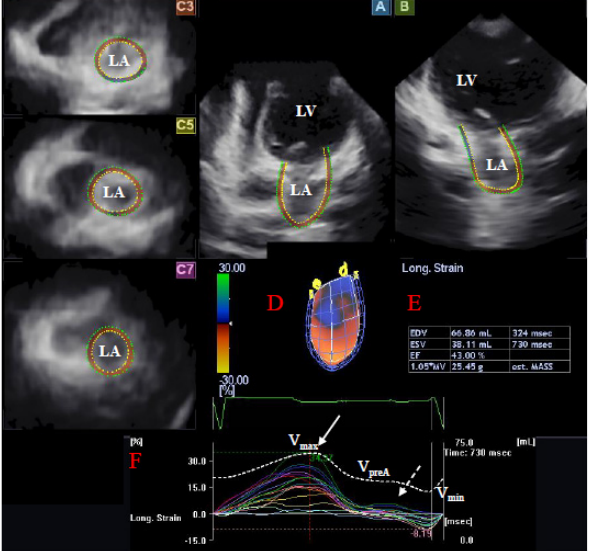
Figure 1. Three-dimensional (3D) speckle-tracking echocardiographic left atrial (LA) analysis using a full-volume dataset in an operated patient with dextro-transposition of the great arteries is presented: ( A ) apical four-chamber view, ( B ) apical two-chamber view, ( C3 ) short-axis view at basal, ( C5 ) mid- and ( C7 ) superior left atrial level. The 3D model of the LA ( D ) and LA volumetric data ( E ) are also presented. Colored curves represent time–LA segmental strains, while dashed curve represents LA volume changes during the cardiac cycle with maximum (V max ), minimum (V min ) LA volumes, and LA volume before atrial contraction (V preA ) ( F ). White arrow represents peak LA strain, while dashed arrow represents LA strain at atrial contraction ( F ). LA = left atrium, LV = left ventricle, V max = maximum LA volume, V min = minimum LA volume, V preA = LA volume before atrial